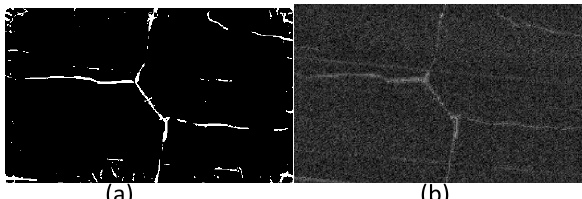
Figure 9. Results obtained by the proposed method (a) detected cracks containing a small road segment, (b) the corresponding DTM high-pass convolution result.